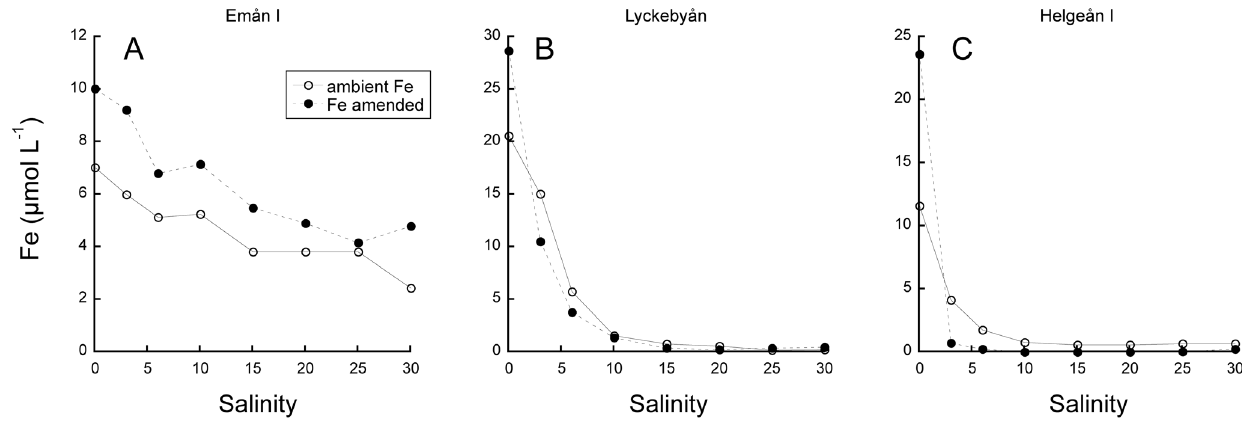
Figure 5. Concentration of iron in suspension at different salinity with and without iron amendments.